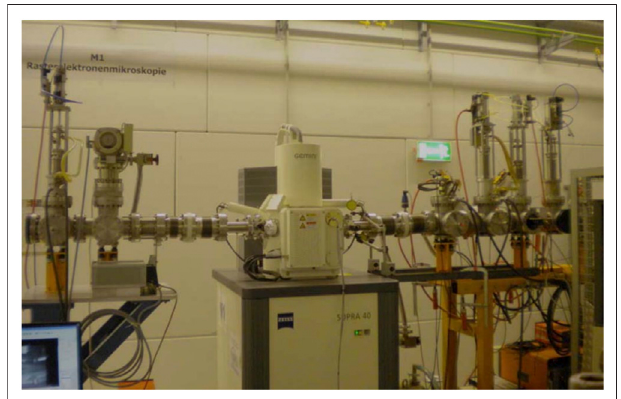
FIGURE 7 | High-resolution scanning electron microscope (Amirthapandian,